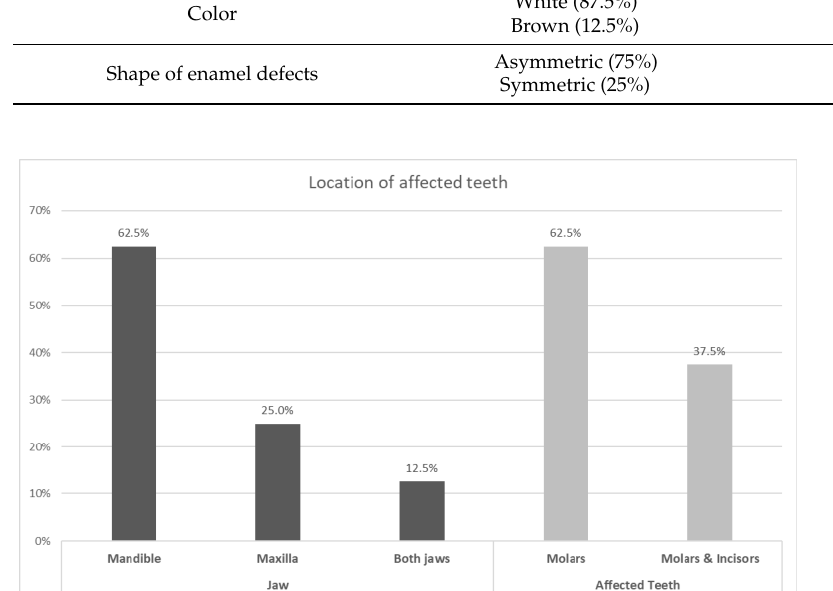
Figure 1. Locations and types of affected